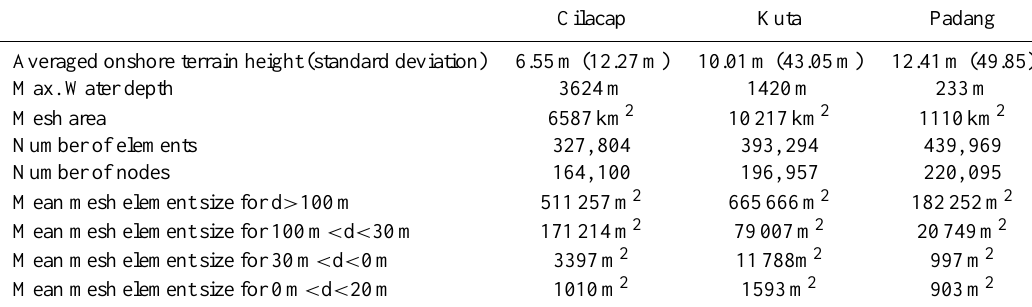
Table 1. Mesh characteristics of study